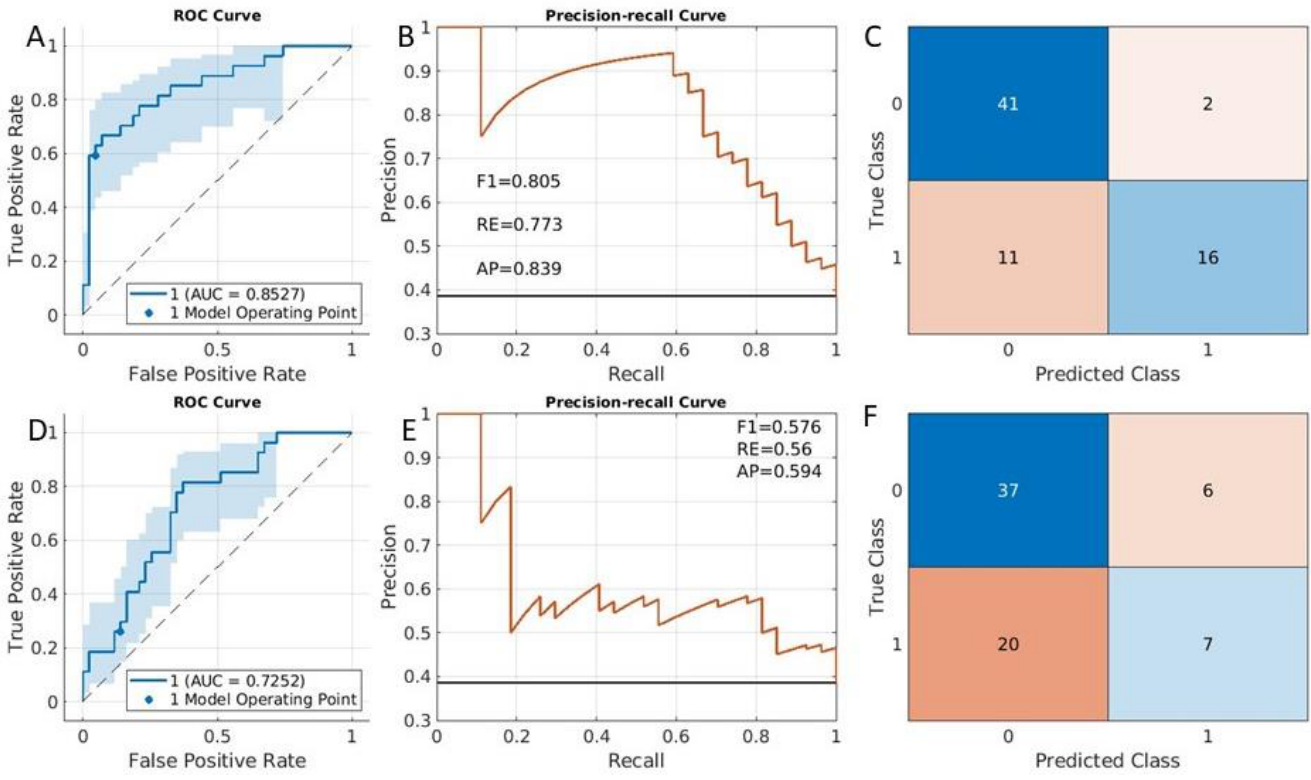
Figure 6. Lymphovascular space invasion prediction from testing datasets. ROC curves ( A , D ), precision–recall curves ( B , E ). confusion matrix ( C , F ). ( A – C ) were obtained from classification kernel classifier determined by the fitcauto method. ( D – F ) were obtained from the LASSO method.